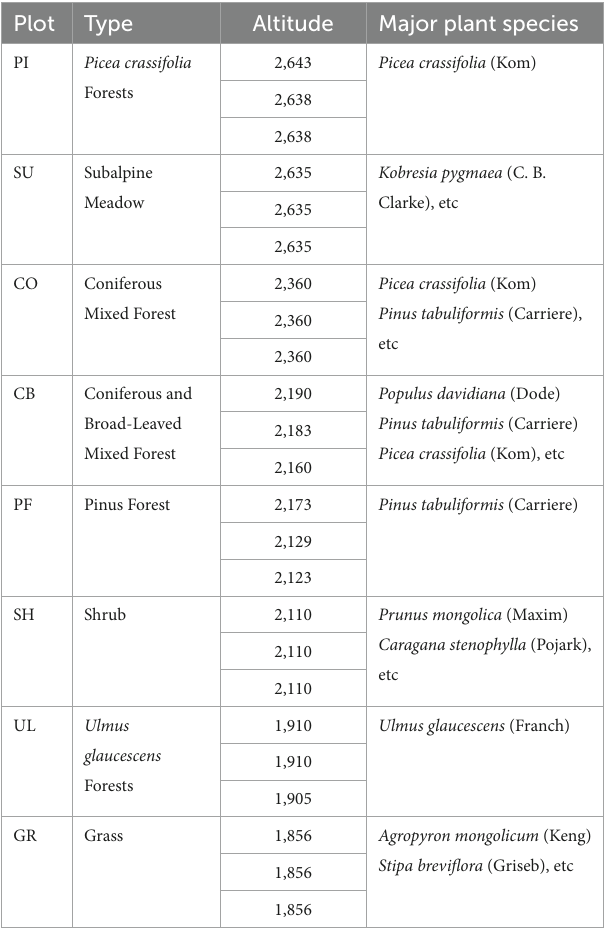
TABLE 1 Basic information about the sample